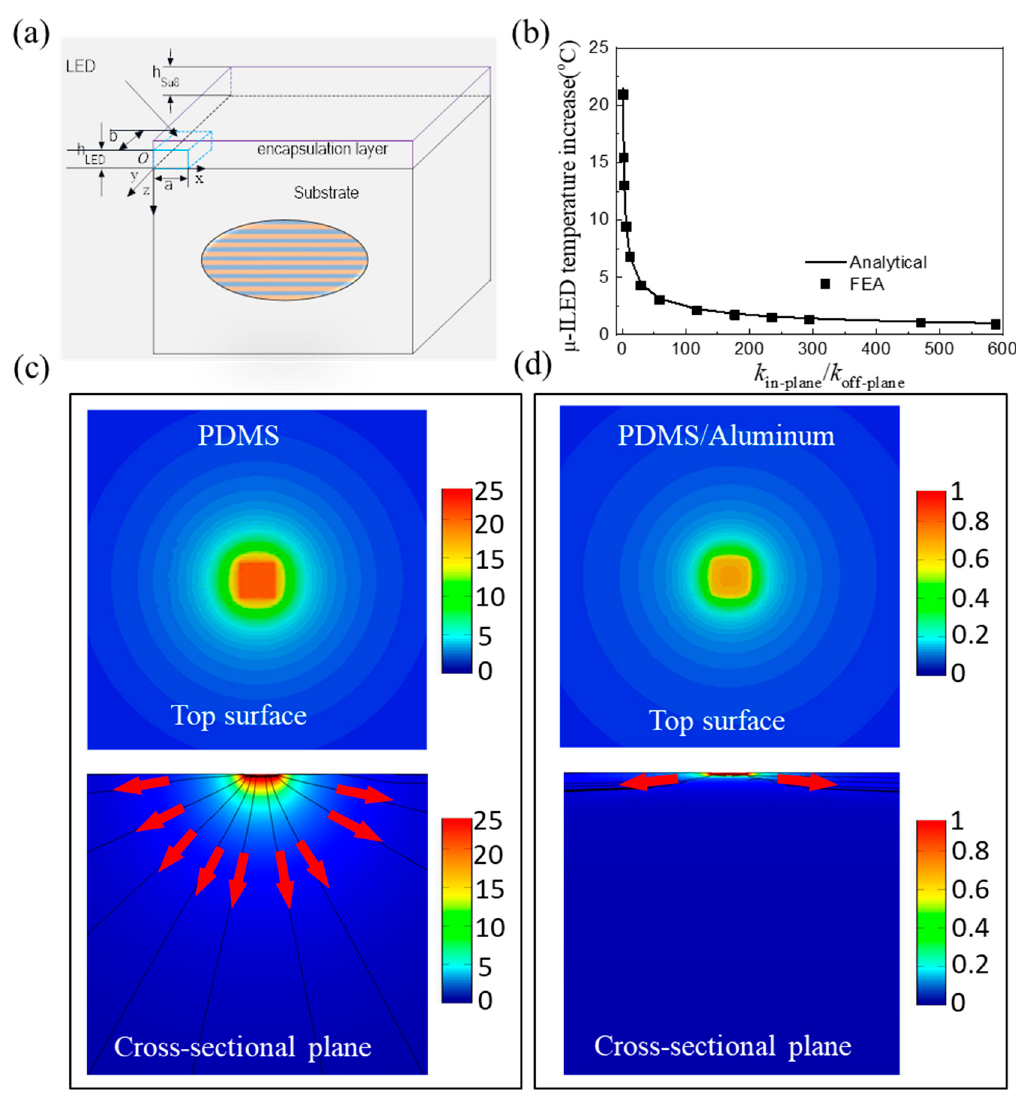
Figure 8. ( a ) Scheme diagram of the µ -ILED device on an orthotropic substrate consisting of two layered materials [83]. ( b ) The temperature increase of the µ -ILED versus the thermal conductivity ratio [83]. Distributions of temperature increase for the µ -ILED device on the ( c ) isotropic and ( d ) orthotropic substrate [83].